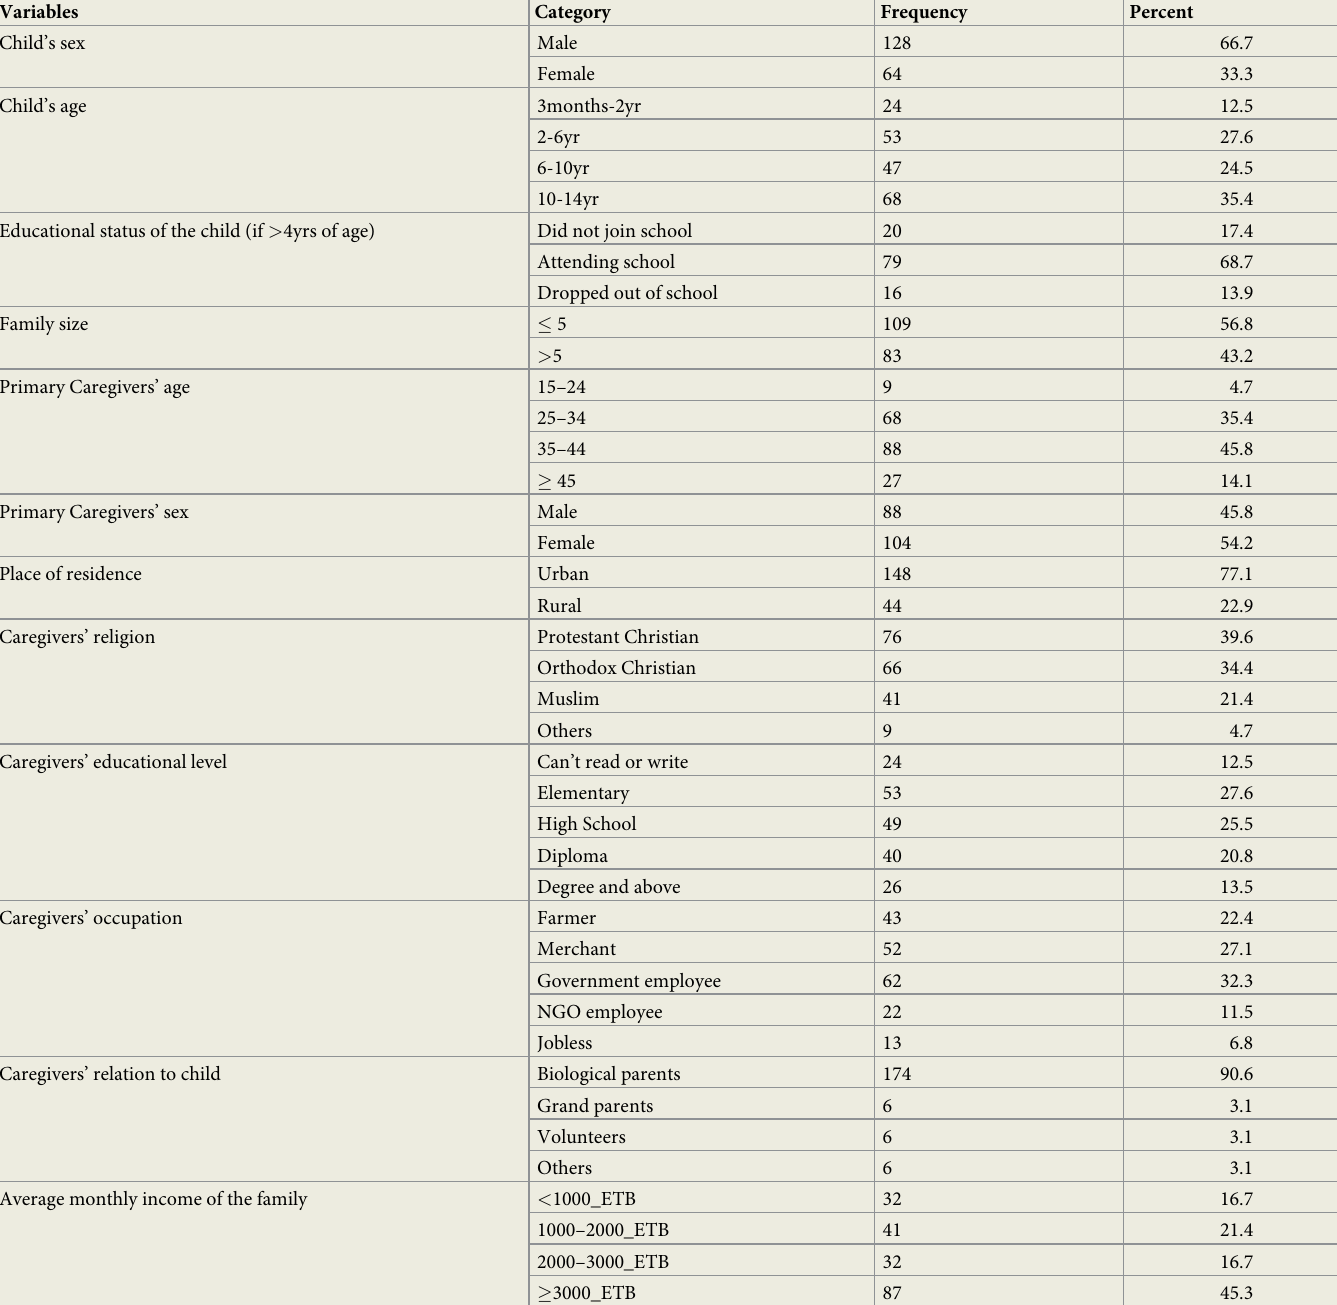
Table 1. Socio-demographic characteristics of caregivers and children on AEDs (n =